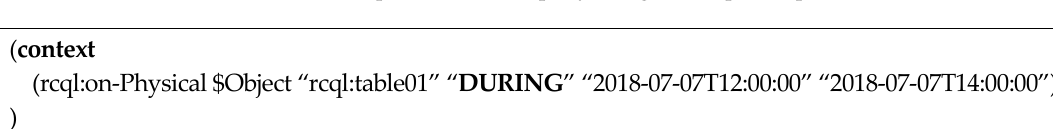
Figure 9. An example of a context query using a time-interval operator.